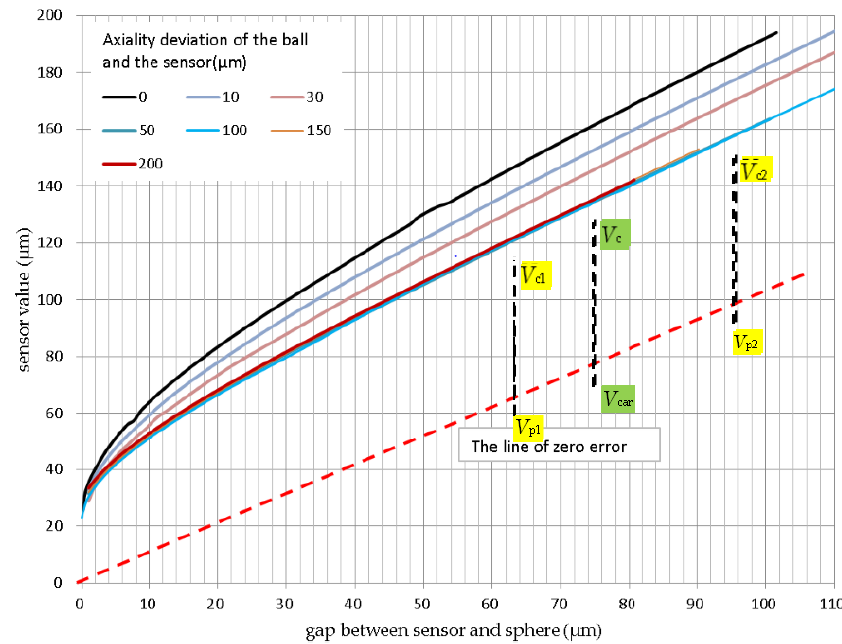
Figure 7. Error characteristic of a capacitive sensor on sphere (average effect).